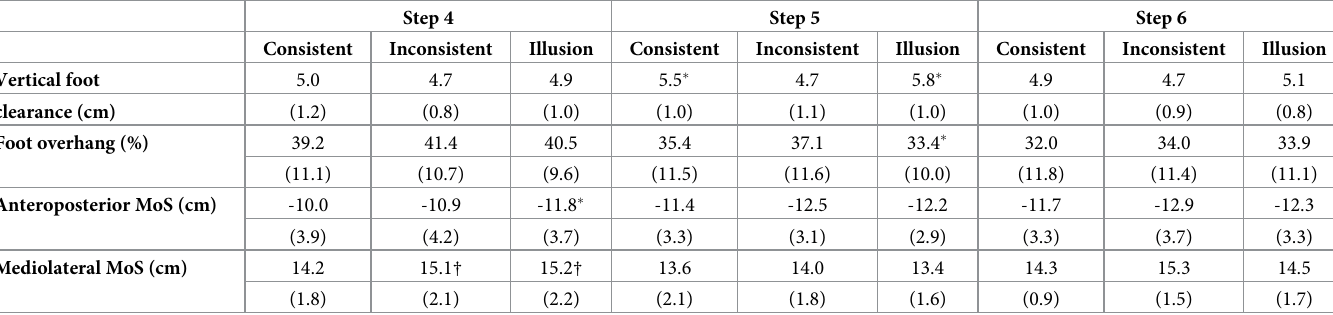
Table 1. Values for vertical foot clearance, foot overhang, anteroposterior MoS and mediolateral MoS on steps 4, 5 and 6 across conditions.